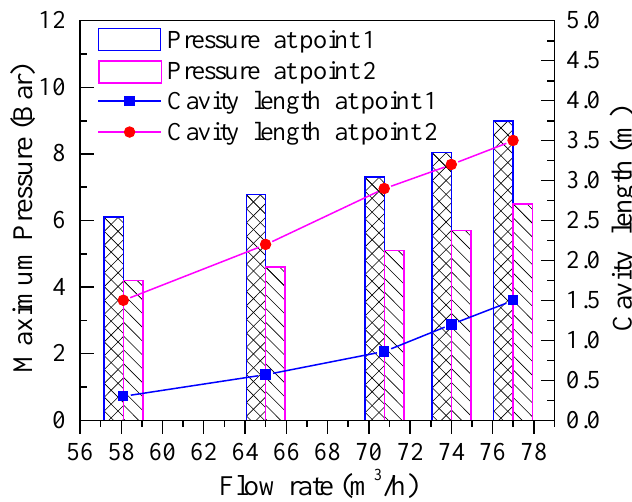
Figure 10. Relationship among the initial flow rate, measured maximum pressure, and cavity length.